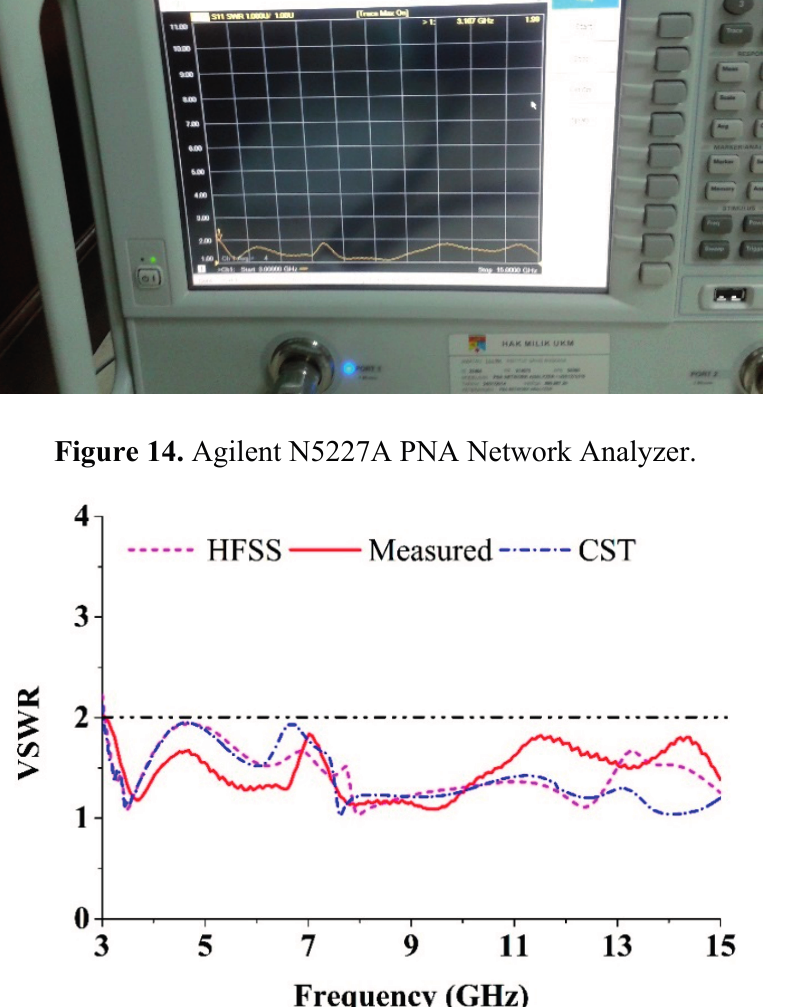
Figure 15. Comparison between simulated and measured